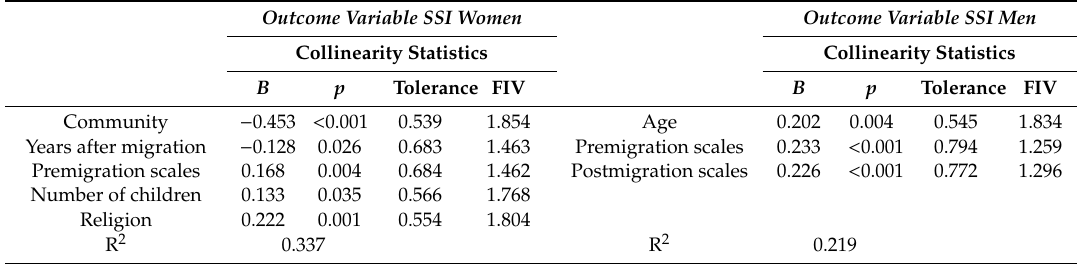
Table 5. Hierarchical lineal regression (enter) of somatic symptoms disaggregated by